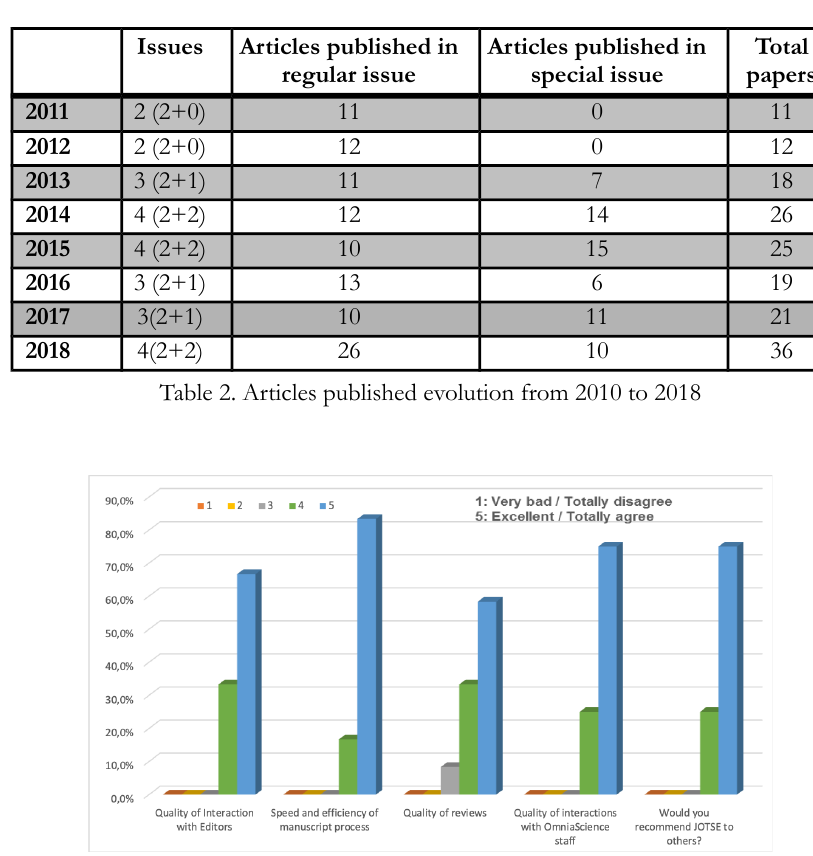
Figure 2. JOTSE author survey results 2018